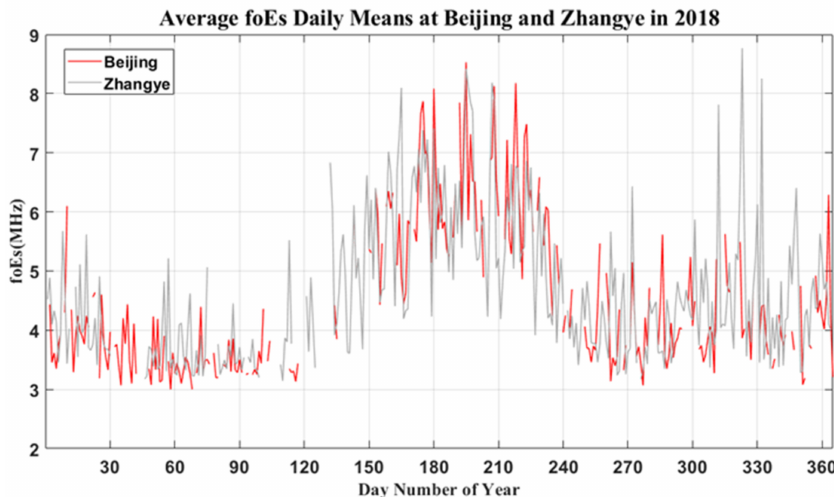
Figure 10. Comparison of the annual variation in daily mean of foEs measured by the Beijing ionosonde (red) and Zhangye ionosonde (grey) in 2018.